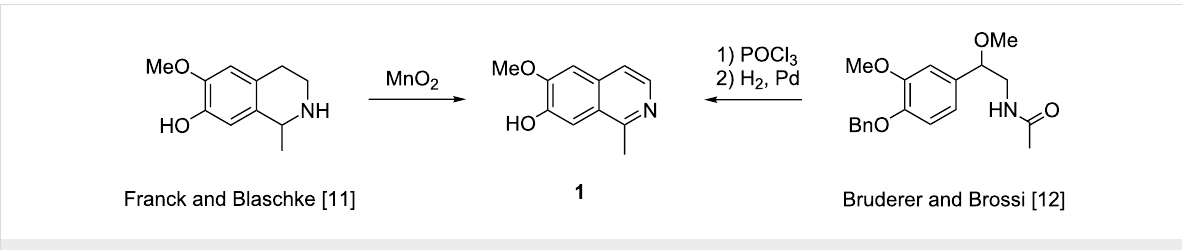
Figure 1: Previously published total syntheses of alkaloid 1